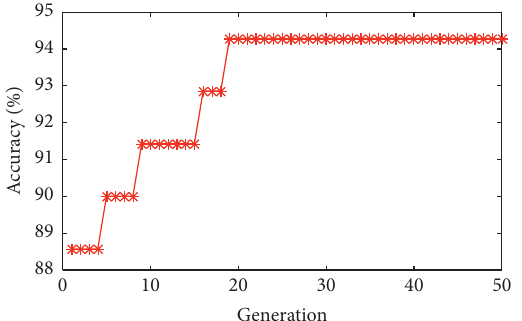
Figure 9: QGA optimization results.